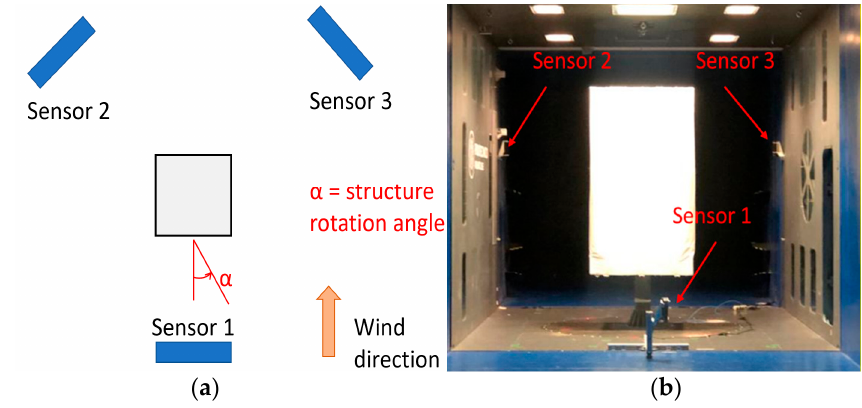
Figure 3. Scheme of the sensor positions ( a ) and actual positions ( b